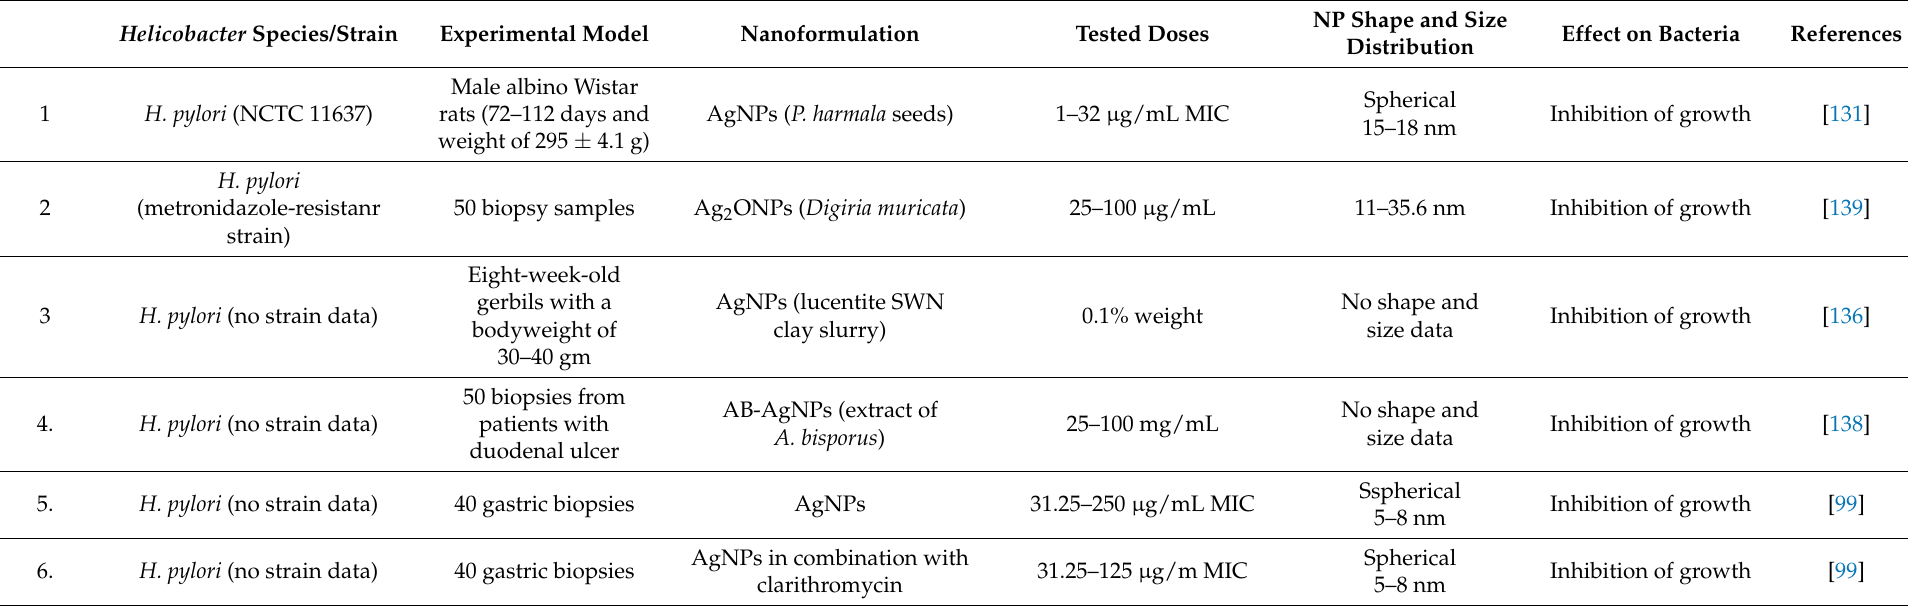
Table 3. Synopsis of the in vivo studies using AgNPs in the treatment of Helicobacter spp.-induced